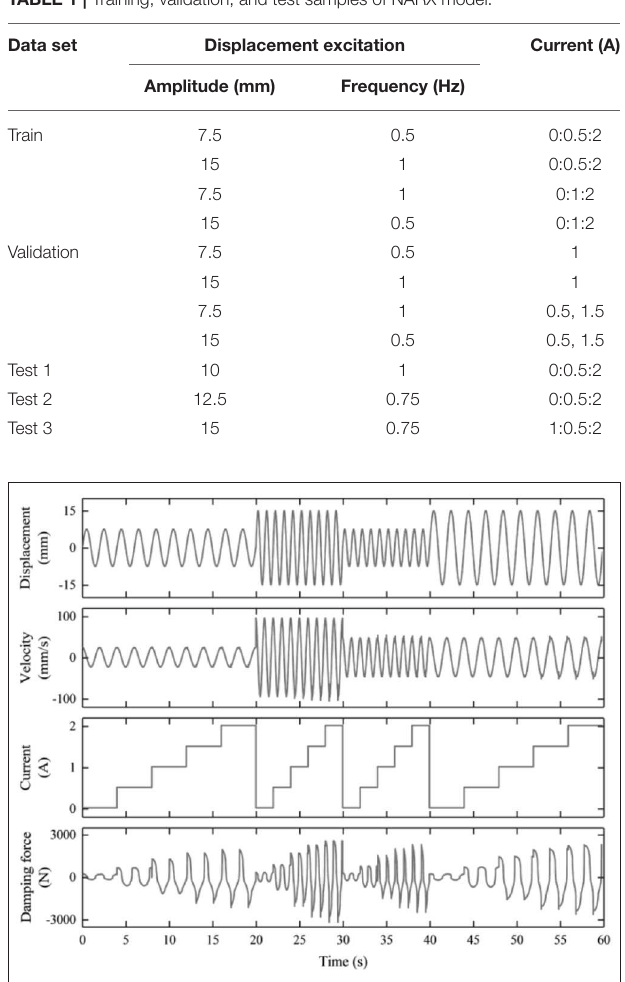
TABLE 1 | Training, validation, and test samples of NARX model.